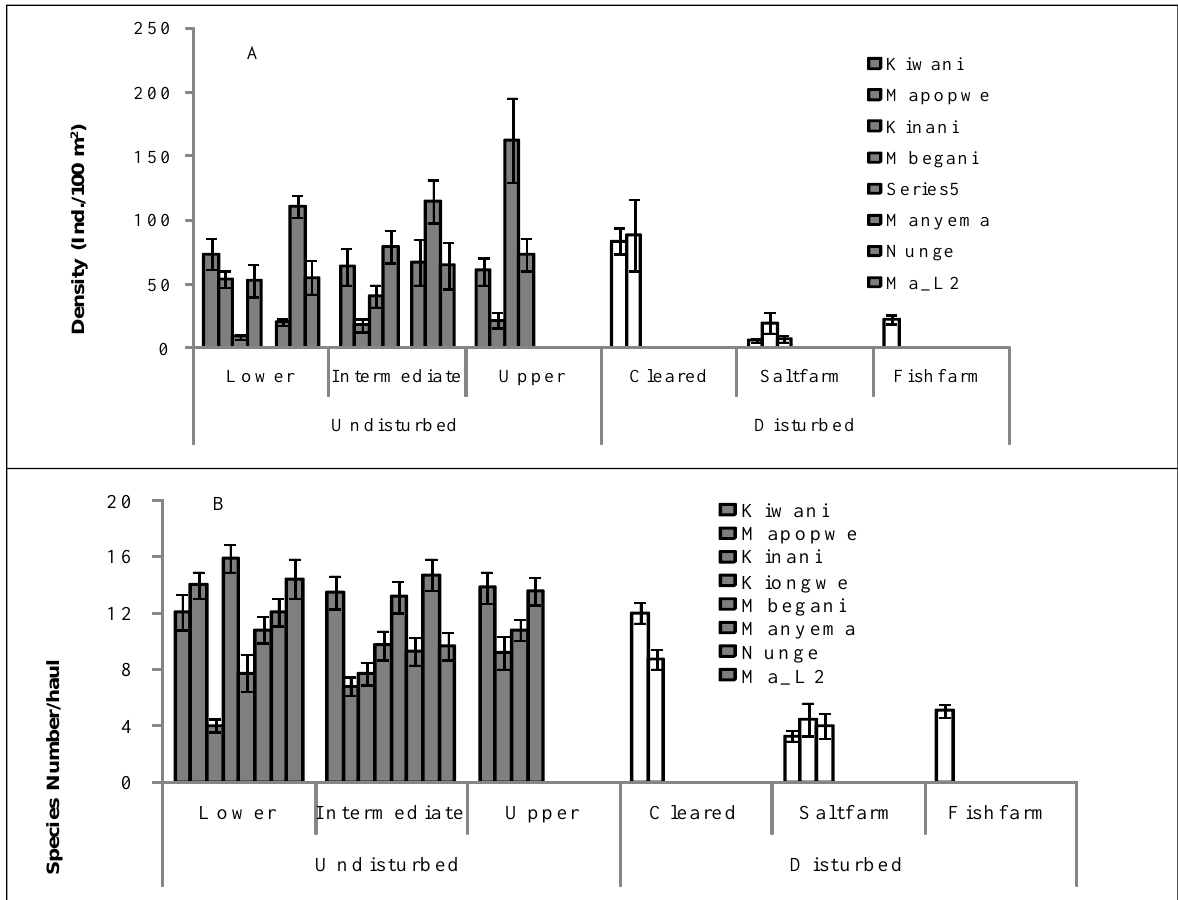
Figure 2: Mean (± SE) of (A) Density (B) Species number and (C) Diversity ( H ') of fish in undisturbed sites (grey bars) in different parts (lower, intermediate and upper) of the creecks and in disturbed sites (white bars) at the upper parts of various crreek